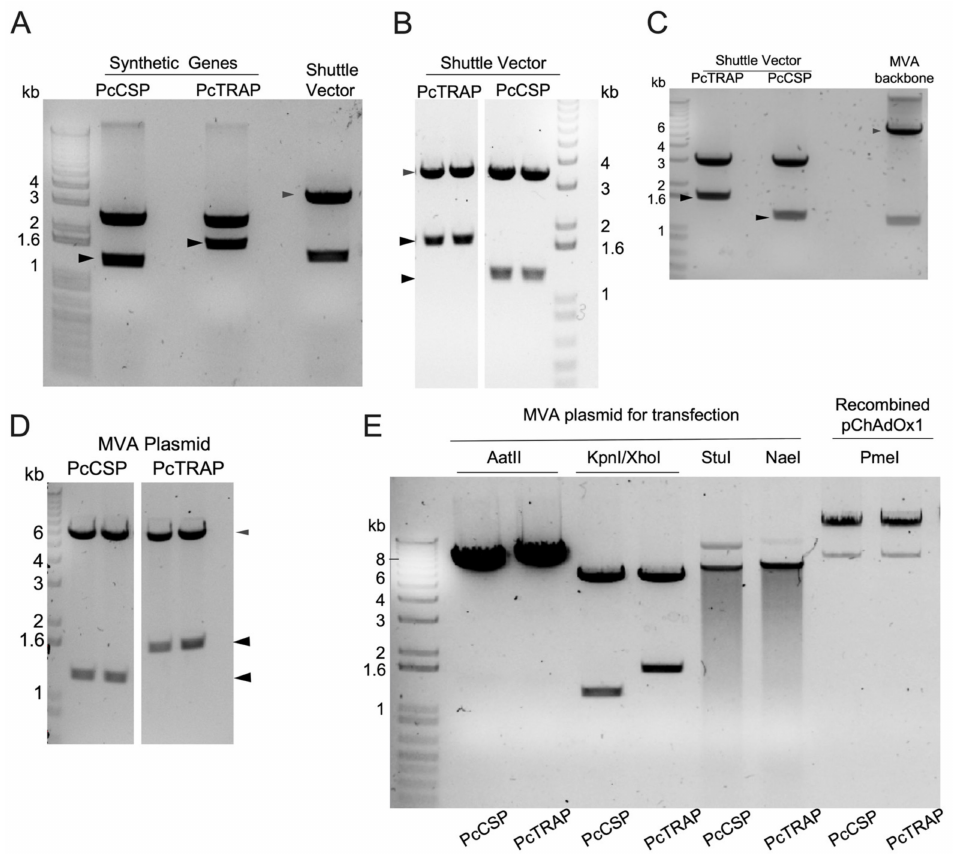
Figure 1. Design, cloning and production of ChAdOx1 and MVA viral vectored vaccines expressing P. cynomolgi (Pc) circumsporozoite protein (PcCSP) and Thrombospondin Related Adhesive